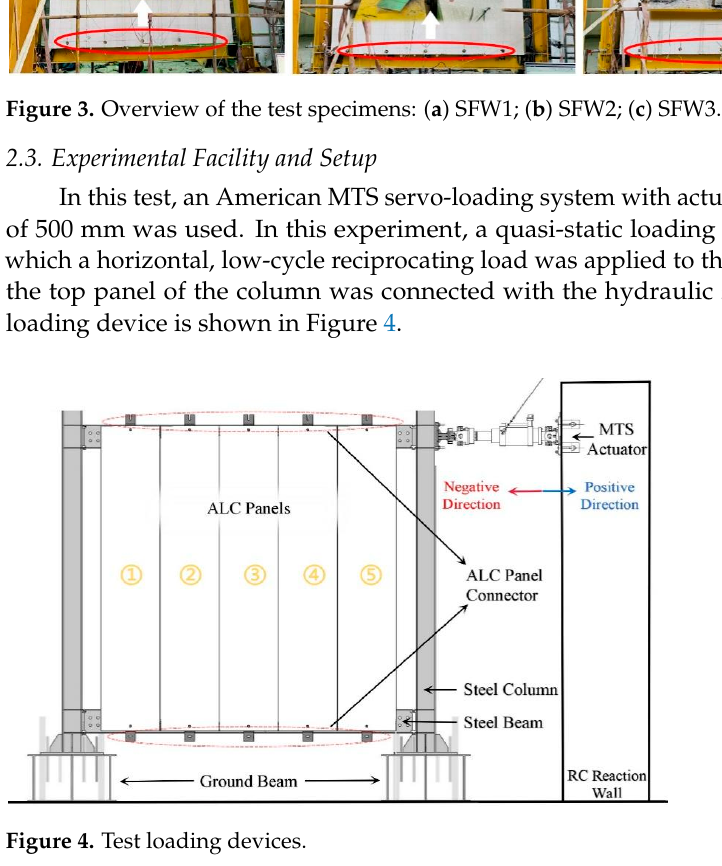
( b ) Figure 5. Photograph of the test devices: ( a ) MTS servo-loading system; ( b ) the actuator of MTS with column. 2.4. Material Properties Six 100 mm × 100 mm × 100 mm and three 100 mm × 100 mm × 300 mm ALC cube test blocks were poured under the same conditions, as shown in Figure 6. All samples were manufactured and maintained under the same conditions, according to “The test methods for autoclaved aerated concrete” (GB/T 11969-2020) [24]. For the steel properties, steel coupons, according to GB/T 228.1-2010 [25], were cut from steel tubes and sheets and assessed to determine the tensile strength, modulus of elasticity, as well as breaking elon- gation. Table 2 shows the results of the steel material tests. Table 3 shows the ALC panel mechanical performance index.